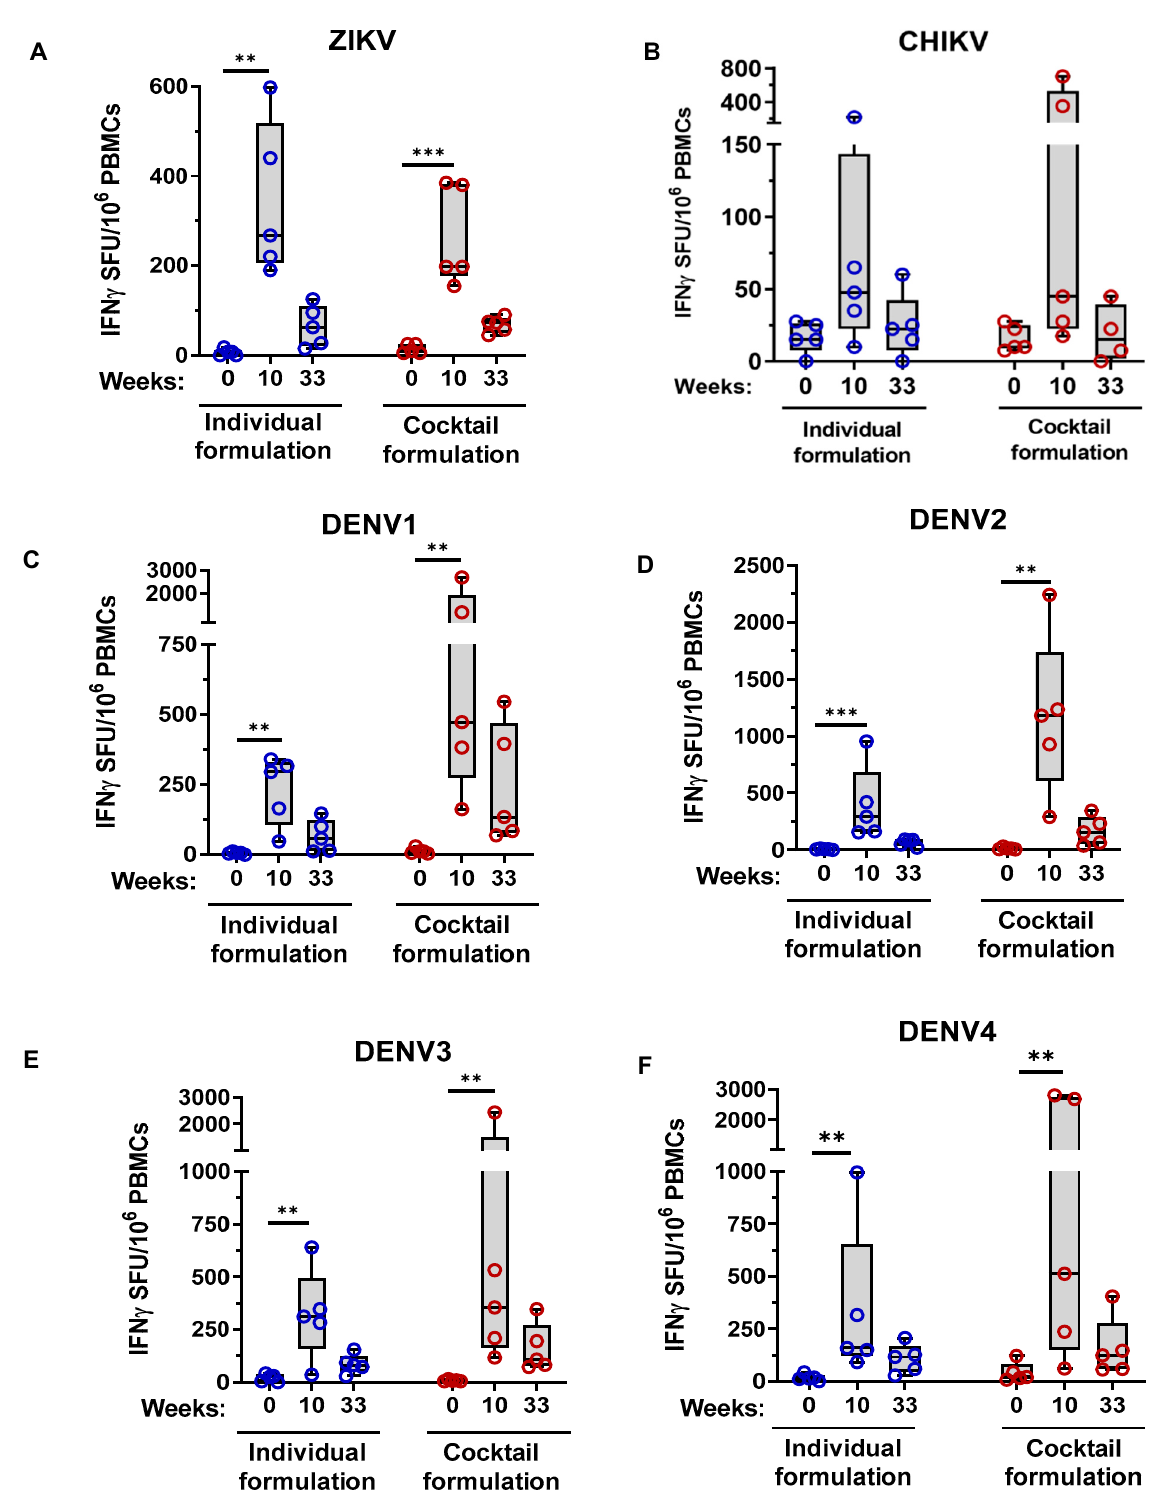
Figure 7. Durability of MMBV DNA vaccine induced cellular immune responses in NHPs. Rhesus macaques were immunized as described in Figure 4. Specific T cell responses for individual NHPs were measured at six months (week 33) post final immunization by IFNy ELISpot following stimulation of PBMCs with ( A ) ZIKV, ( B ) CHIKV, ( C ) DENV1, ( D ) DENV2, ( E ) DENV3, and ( F ) DENV4 envelope peptide pools. Asterisks indicate significant difference in SFUs compared to week 0 as described in the methods. There were no significant differences between individual and cocktail formulation treatment groups.